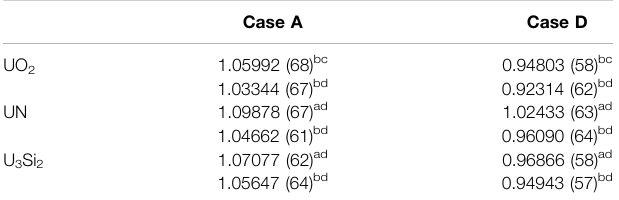
TABLE 5 | k eff of the LANL design and the annular fuel design for case A and case D under 900